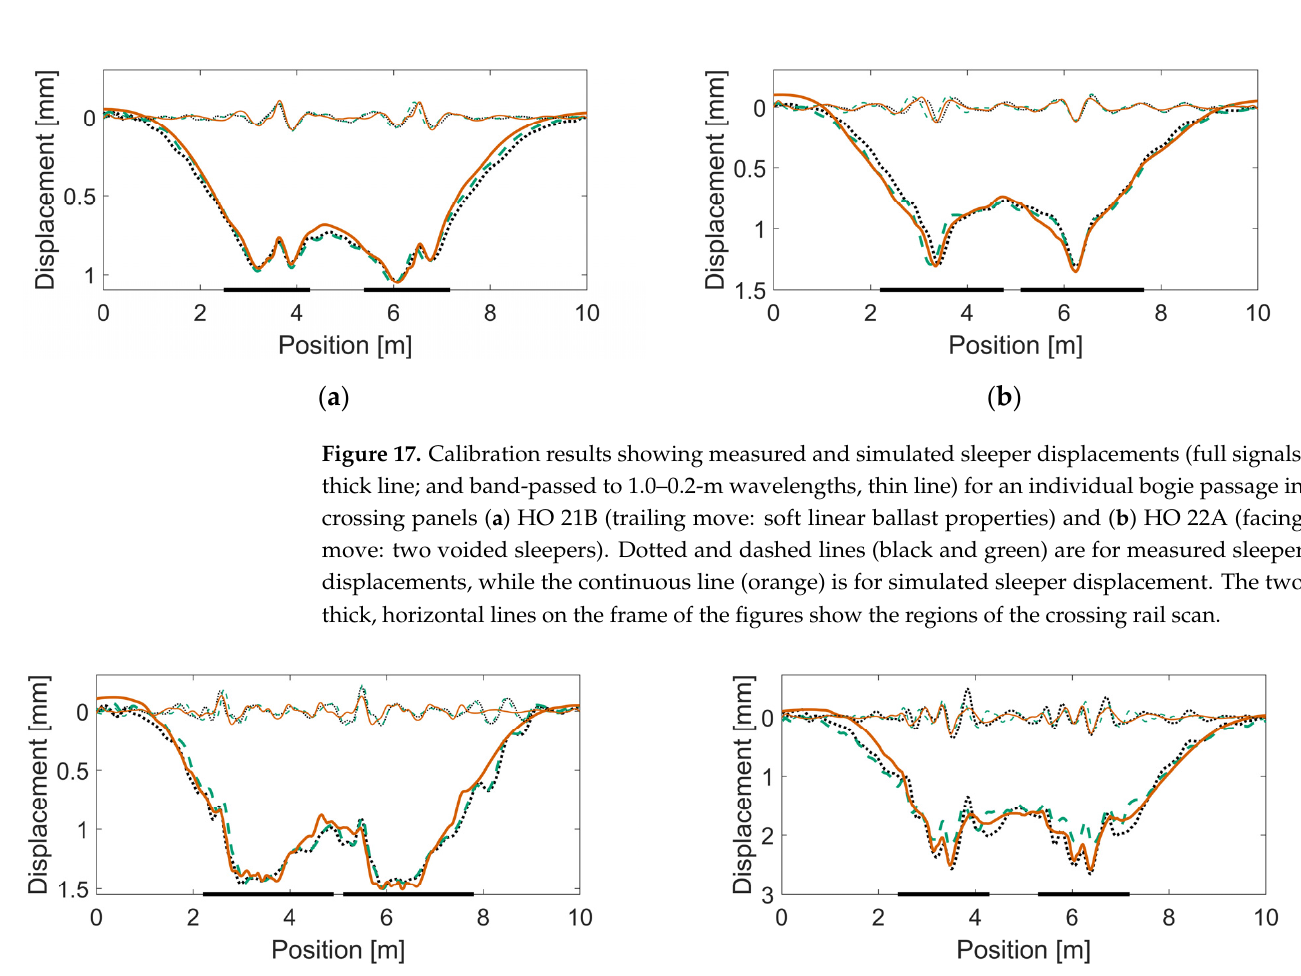
Figure 18. Calibration results showing measured and simulated sleeper displacements for an individual bogie passage in